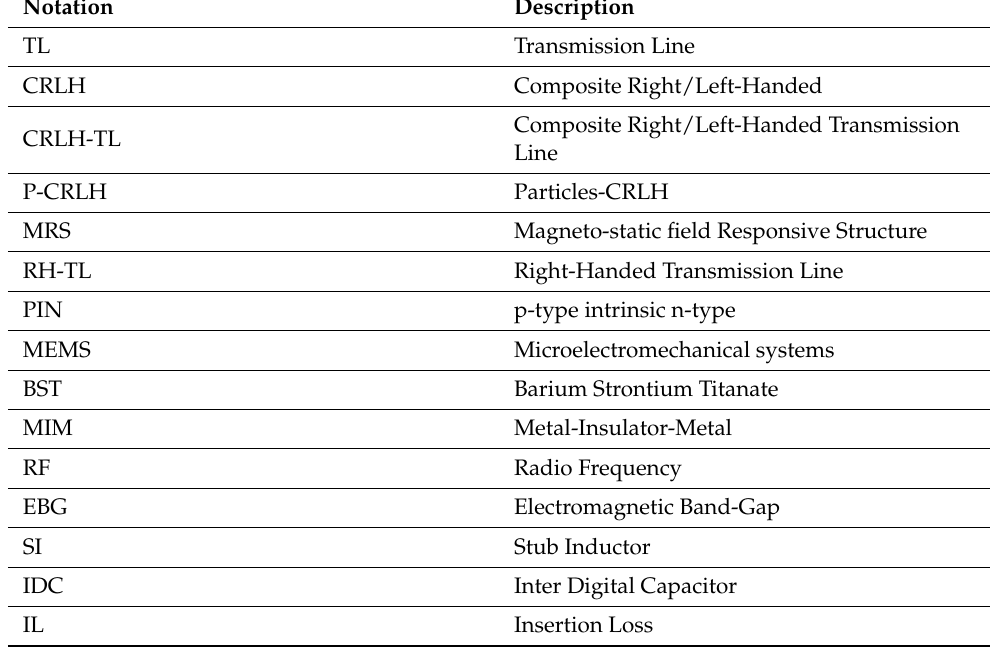
Table A1. Abbreviations used in the